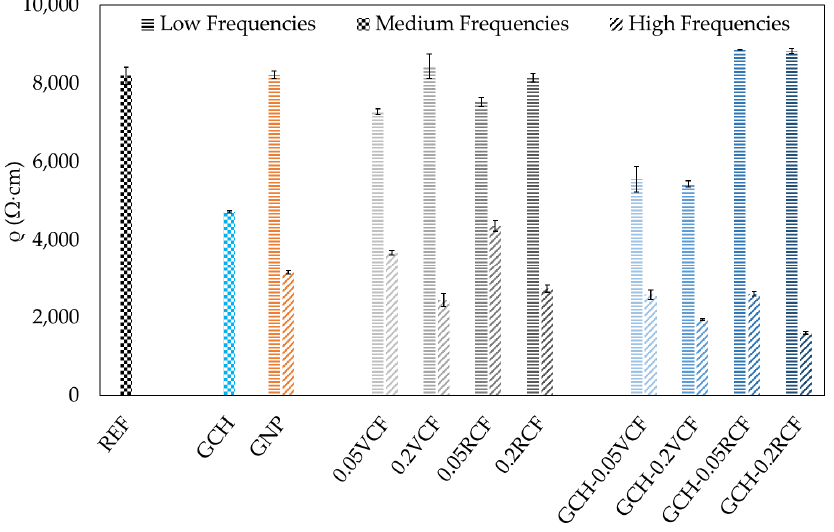
Figure 10. Electrical resistivity ( ρ ) of mortars after 28 days of curing measured in AC at low, medium and high frequencies.